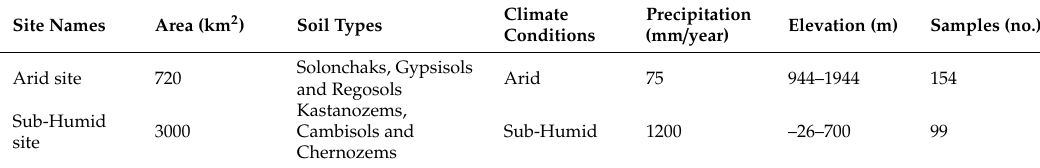
Table 1. Study sites and data collection details.